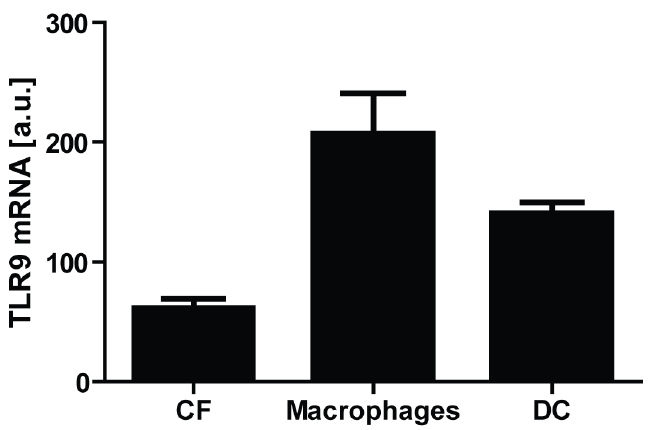
Figure 2. TLR9 mRNA levels in cultivated murine cardiac fibroblasts (CF; n=3), bone marrow derived macrophages (n=3) and dendritic cells (DC; n=3). Data presented as mean 6